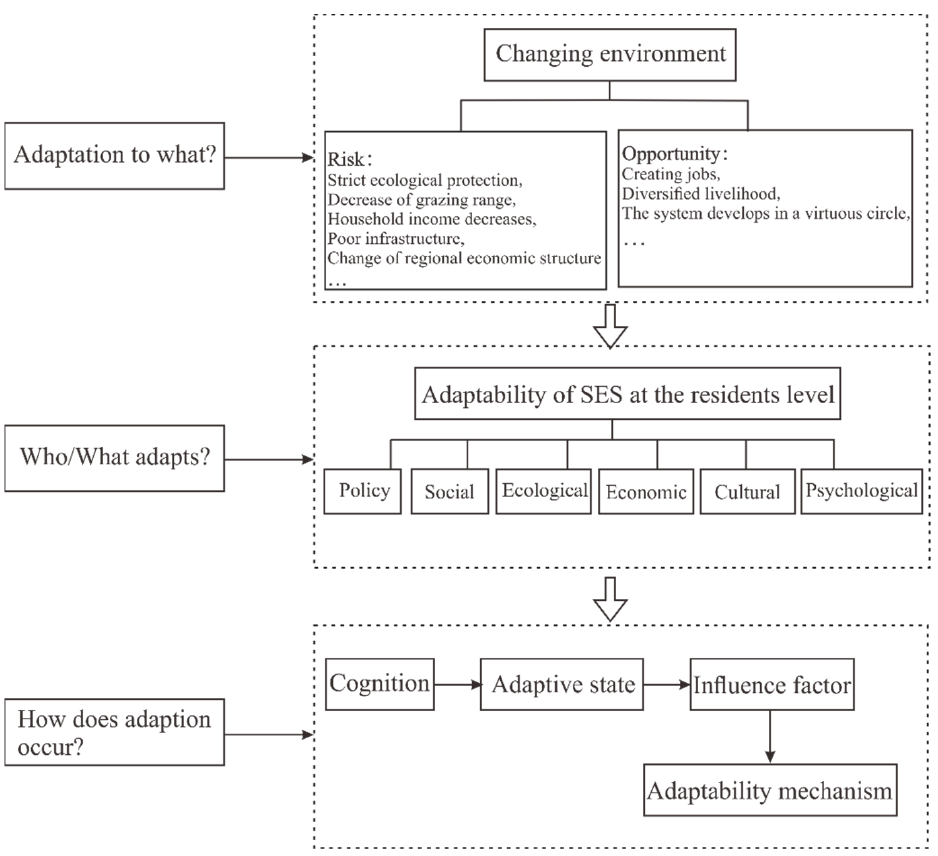
Figure 2. Analysis framework of residents’ adaptability in the QMNPP (adopted from Smit et al. (1999) [25]).